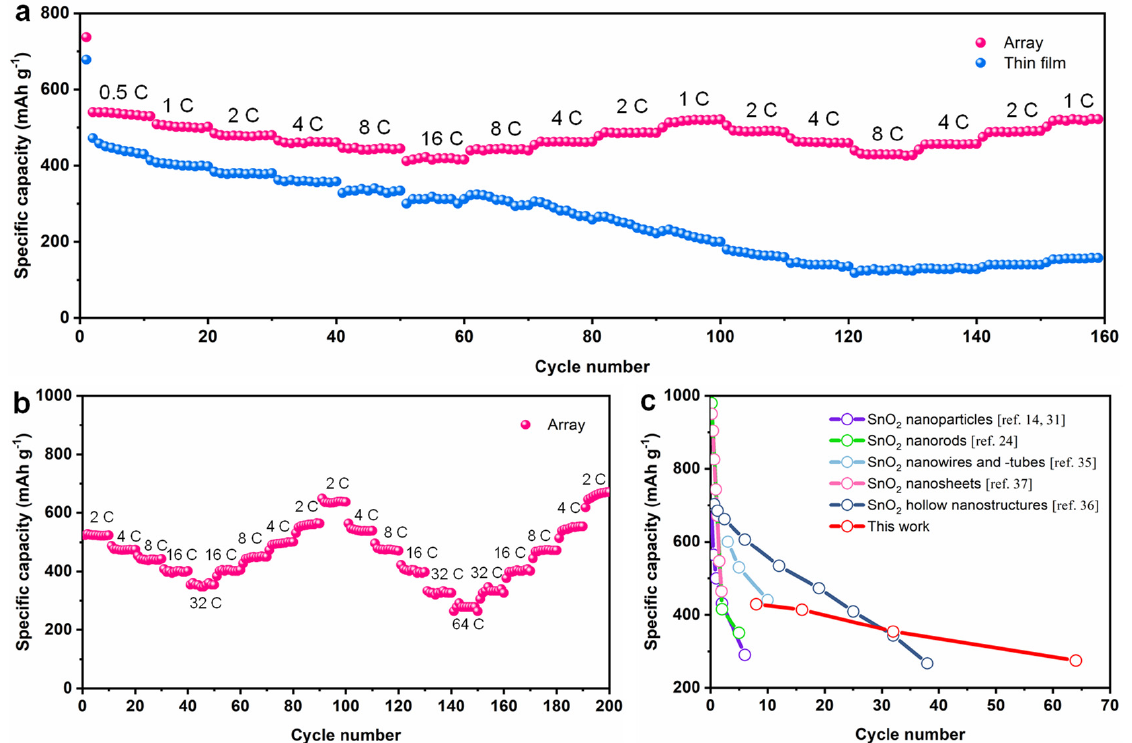
Figure 4. Rate performance of SnO 2 nanoarray and SnO 2 thin films. ( a ) The rate capability of SnO 2 nanoarray and PLD- fabricated SnO 2 thin film at different current densities, ranging from 0.5 C to 16 C; ( b ) rate capability of SnO 2 nanoarray at different current densities, ranging from 2 C to 64 C; and ( c ) comparison of the electrochemical performance for SnO 2 -based anodes.